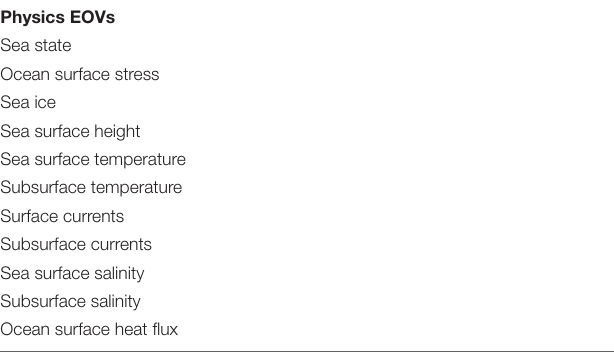
TABLE 3 | GOOS Physics Panel supported EOVs (October